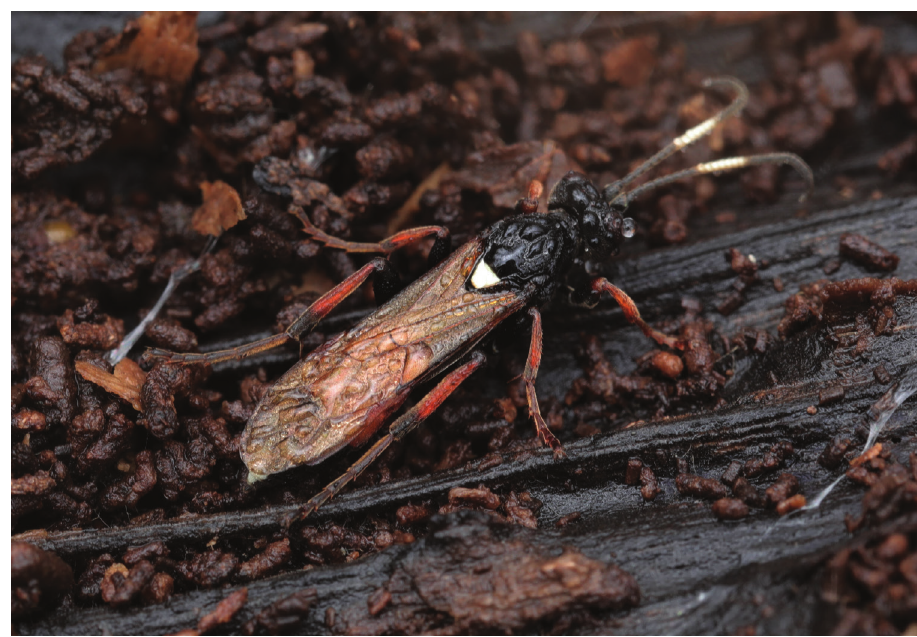
Figure 4. A rare example of a hibernating ichneumonid wasp, Ichneumon bucculentus Wesmael 1845, near hyphae of an Armillaria (Fr.) Staude sp.; Belgium, Moerbeke (Bosberg), 13 January 2021. Patrick